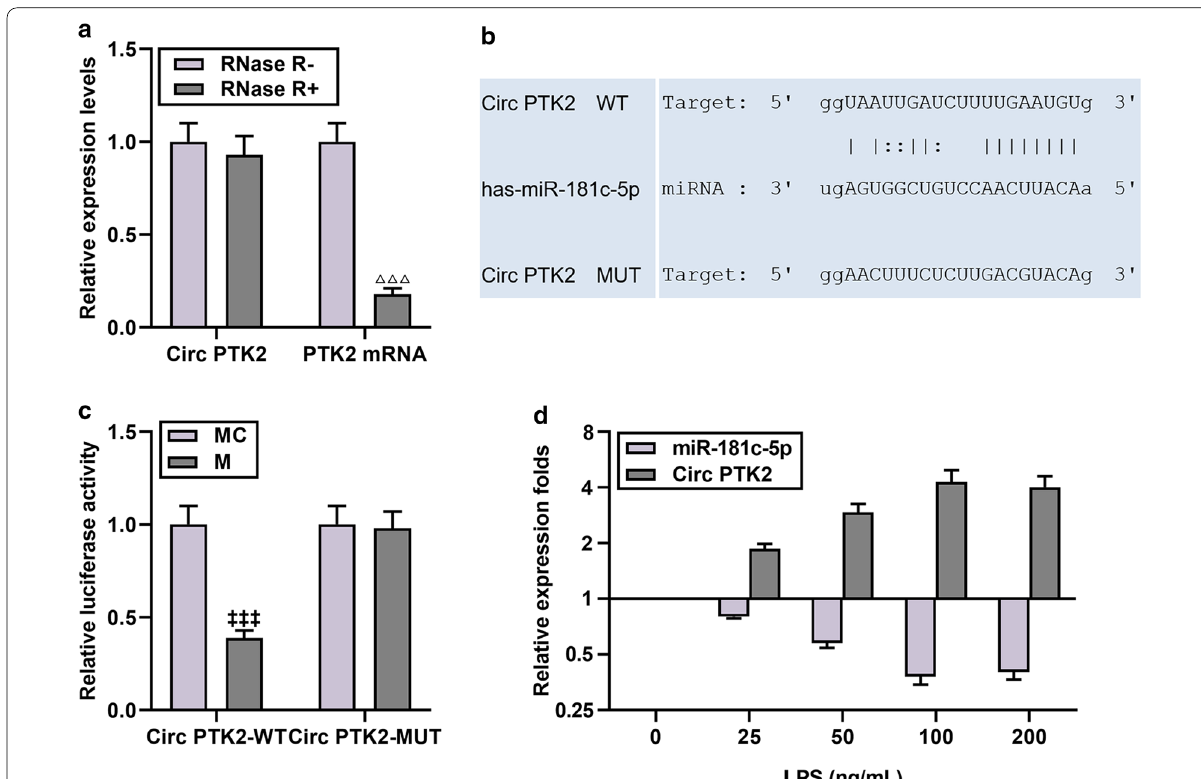
Fig. 5 CircPTK2 directly targeted miR-181c-5p and was negatively correlated with miR-181c-5p in LPS-induced microglia. a After treatment with RNase R, PTK2 level decreased significantly, while CircPTK2 level remained unchanged. N The results from starBase v2.0 (http:// starb ase. sysu. edu. cn/ starb ase2/) and c dual luciferase assay showed that circPTK2 could target miR-181c-5p. N 3 for each column; ‡‡‡ P < 0.001 t test vs MC. d After induction with different doses of LPS, qRT-PCR was used to detect the expressions of = miR-181c-5p and circPTK2 in microglia. β-actin or U6 was used as a control. N miR-181c-5p mimic; MC miR-181c-5p mimic control; qRT-PCR quantitative reverse transcription real time polymerase chain